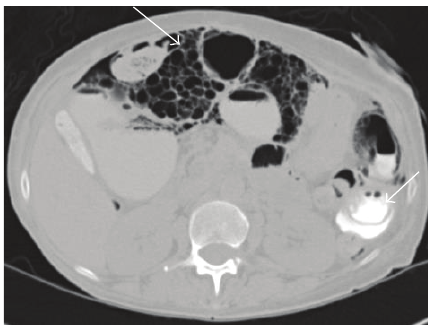
Figure 3: Axial CT image with enteric contrast demonstrates multiple large “cysts” within the wall of the small bowel (arrows). Enteric contrast is visualized within the lumen of small bowel at the left side of the abdomen, without extravasation (dashed arrows).